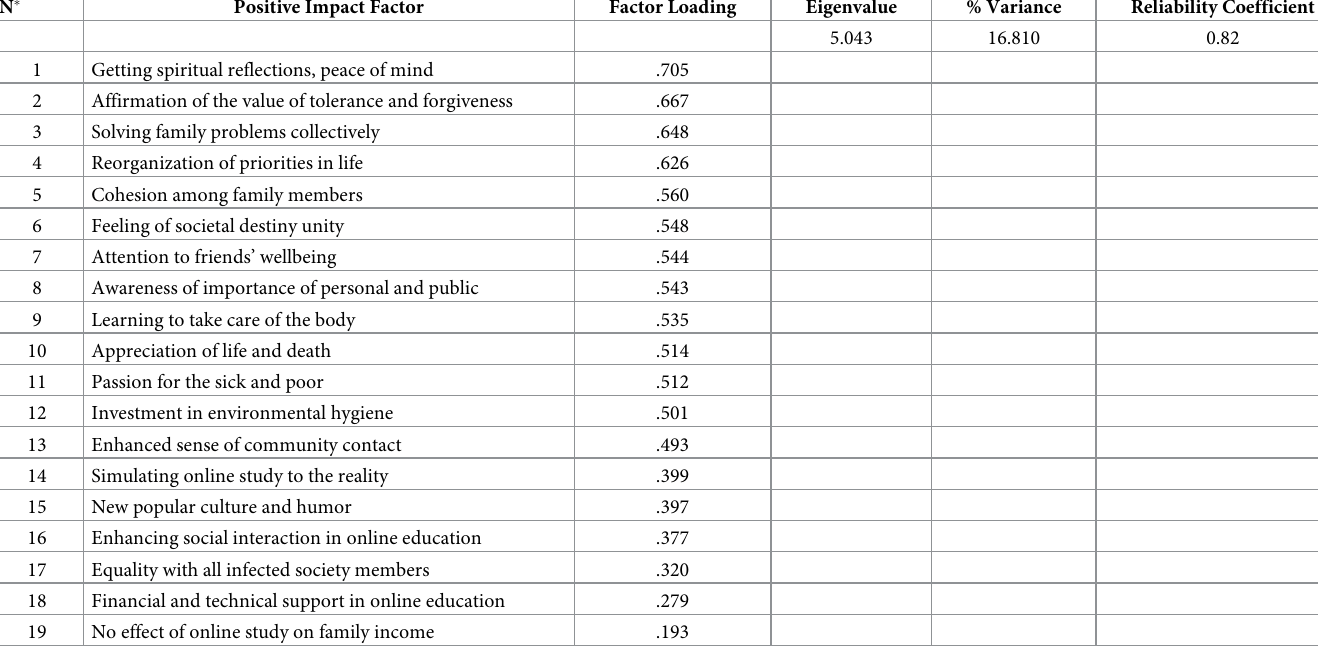
Table 2. Total variance explained by the factor of the positive impact of COVID-19 pandemic